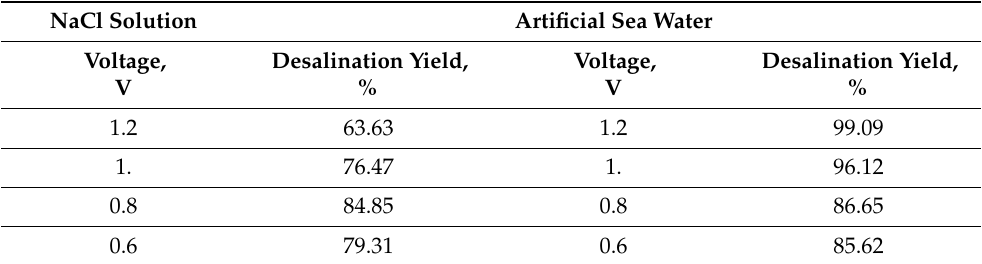
Table 5. CDI module desalination yields for the test solution at different applied